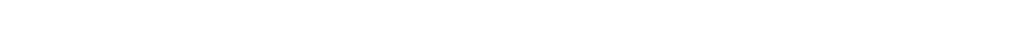
FIGURE 1 | Location and sampling stations of the lakes studied in California and Nevada. Black dots represent the sampling